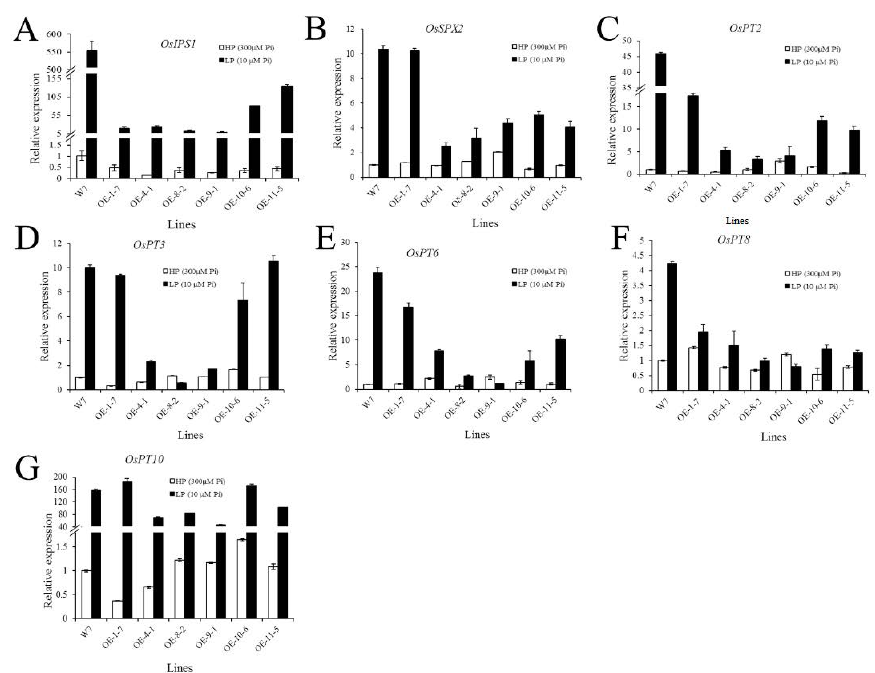
Figure 9. The relative expression analysis of CmPT2 and other PSR gene under different phosphate conditions. Relative expression analysis of OsIPS1 ( A ), OsSPX2 ( B ), OsPT2 ( C ), OsPT3 ( D ), OsPT6 ( E ), OsPT8 ( F ), and OsPT10 ( G ) between W7 and CmPT2 -OE lines under different phosphate conditions. The expression levels of the phosphorus-related genes in G84A-10-3, G222A-4-1, T239A-3-1, Y242A-4-1, and N422A-7-1 were similar to those in CmPT2 -OE-8-1 under HP conditions. Under LP stress, OsIPS1 and OsSPX2 were increased in G84A-10-3, G222A-4- 1, and T239A-3-1, similar to CmPT2 -OE-8-1. By contrast, OsIPS1 and OsSPX2 increased weakly in Y242A-4-1 and N422A-7-1. The expression of OsPT2 and OsPT10 in T239A-3-1 was significantly higher than that in the other strains. Under LP, the expression levels of OsPT3 and OsPT6 were significantly higher in T239A-3-1, Y242A-4-1, and N422A-7-1 than in CmPT2 -OE-8-1, G84A-10-3, and G222A-4-1. The expression of OsPT8 was significantly higher, whereas that of OsPT10 was significantly lower in Y242A -4-1 than in the other strains (Figure 10).